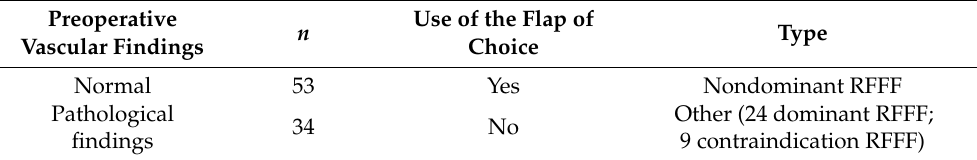
Table 3. Changes in the decision of the flap of choice due to vascular preoperative